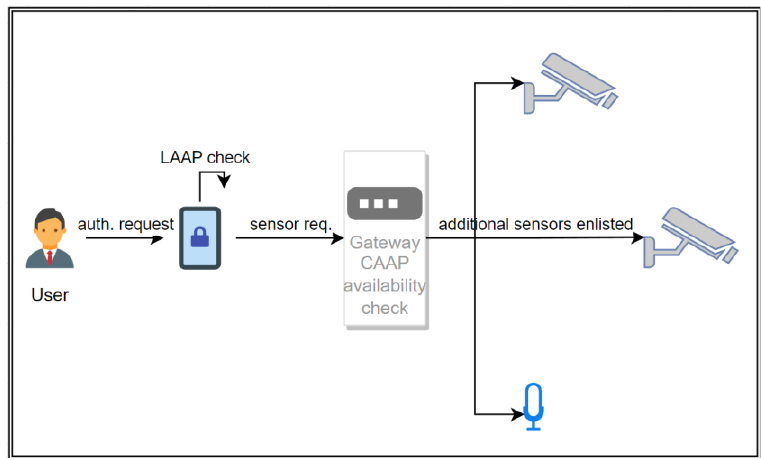
Figure 2. Distributed authentication challenge.